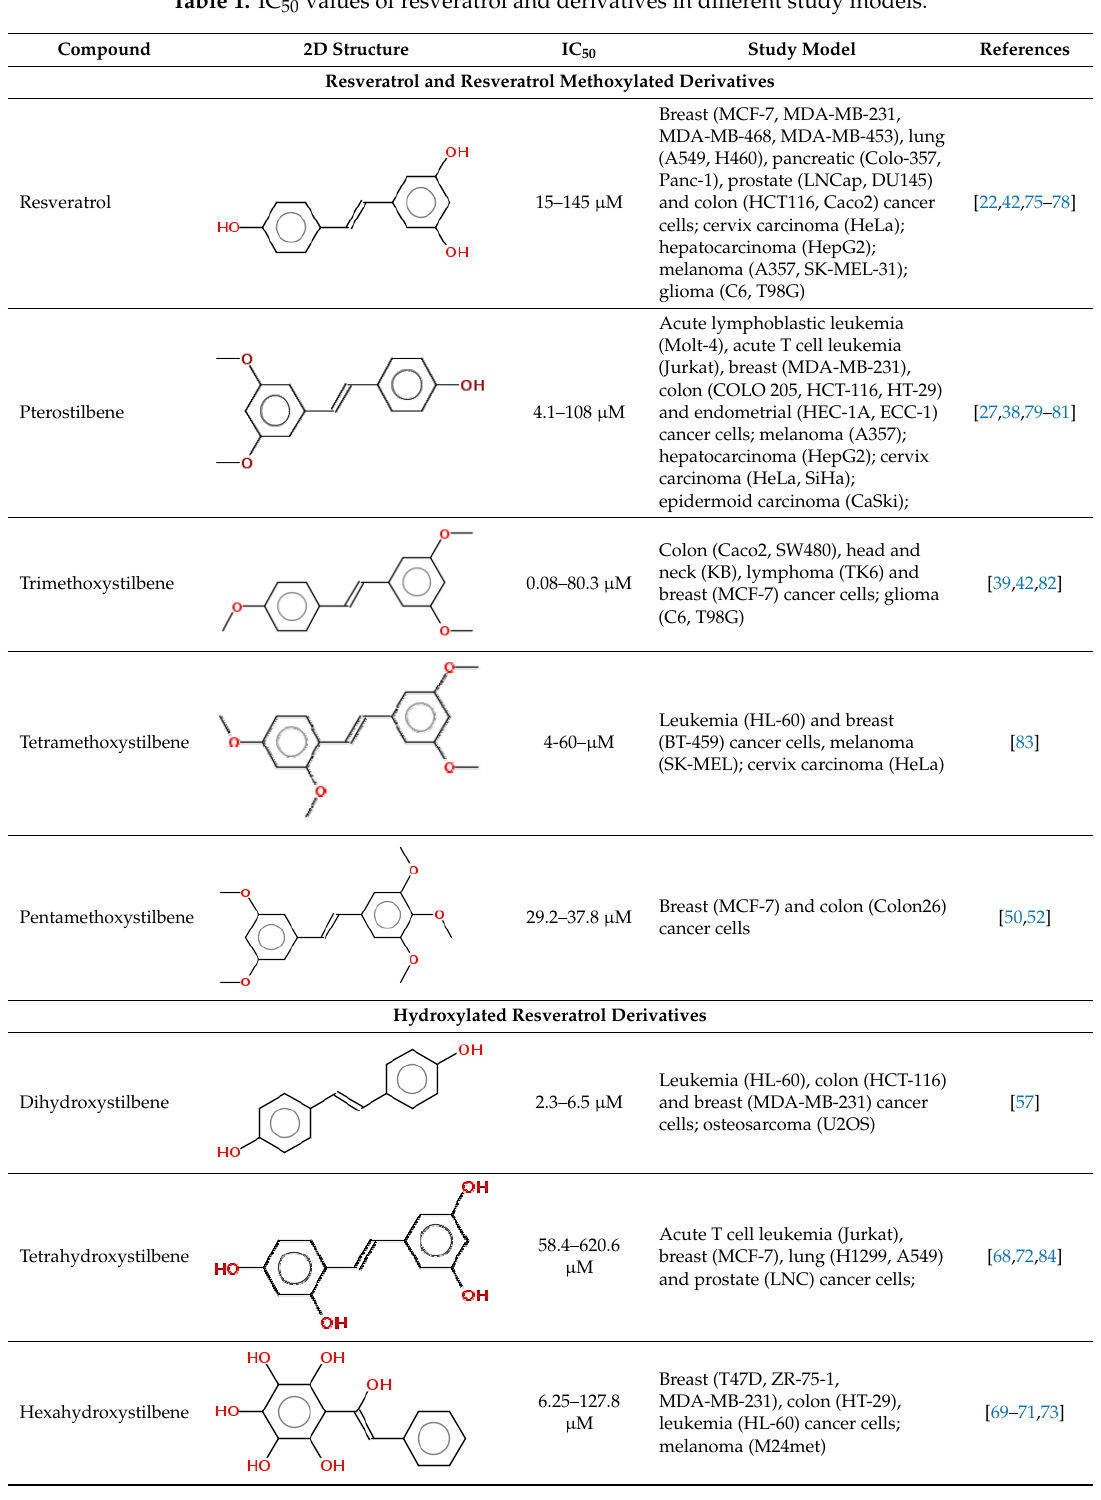
Table 1. IC 50 values of resveratrol and derivatives in different study models.